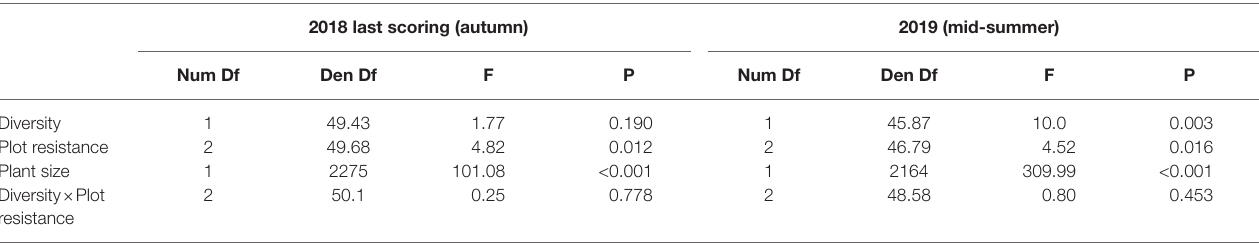
TABLE 2 | Results of generalized linear mixed models testing the effect of genetic diversity ( high and low , with 10 and two varieties, respectively), plot resistance (consisting only of resistant , susceptible varieties, or a 50:50 mixture of the two), and plant size (height × width, cm 2 ) on number of herbivore damaged woodland strawberry ( Fragaria vesca ) leaves in 2018 and in